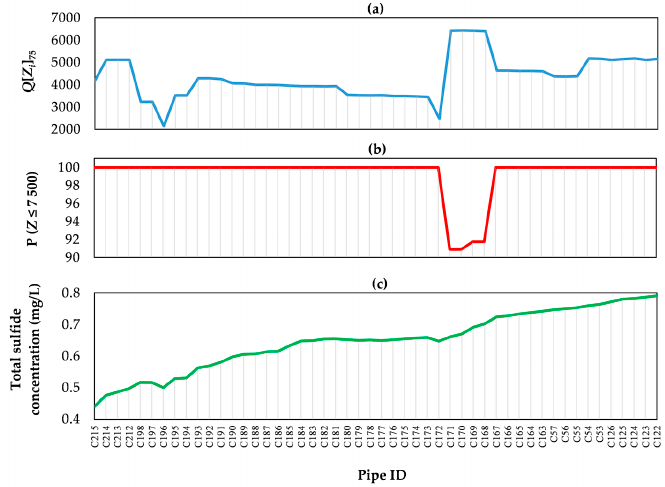
Figure 10. Hydrogen sulfide production across the optimal pipe path of area ID 3. ( a ) The first panel shows the Q [ Z i ] 75 values in all pipes of the path; ( b ) The second panel depicts the non-exceedance probability of the Z ≤ 7500 threshold with respect to the path’s pipes; ( c ) The third panel shows total sulfide concentration inside the pipes according to Equation (9).